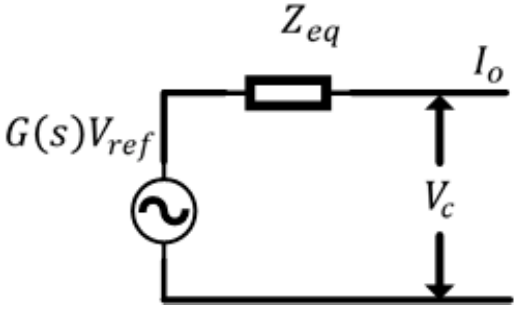
Figure 4. The equivalent circuit of the voltage source.